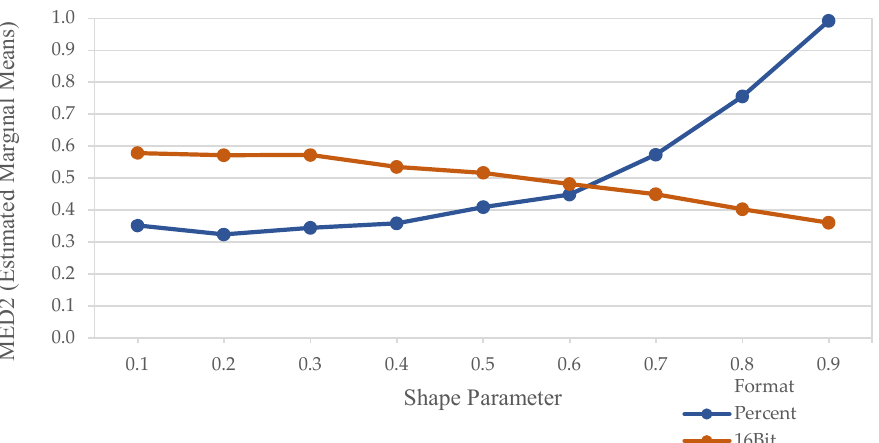
Figure 5. Estimated marginal means of optimal MED2 as a function of reflectance storage scale (Per- cent or 16Bit formats) and shape parameter.